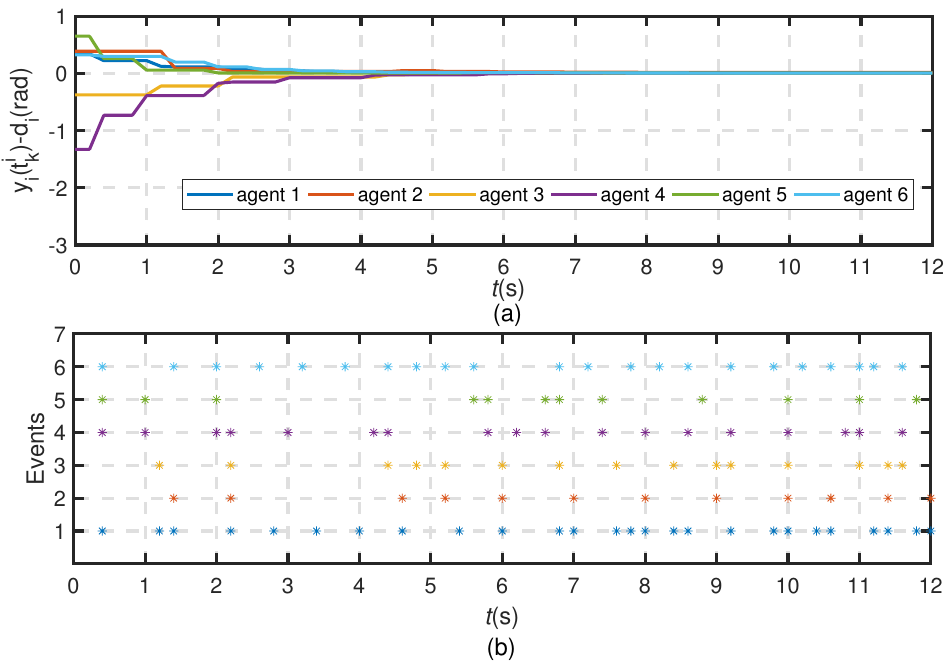
Figure 3. Simulation results of circle formation for MASs: ( a ) The evolution of the Lyapunov function V(t) in Theorem 2. ( b ) The evolution of (cid:107) y i ( t i